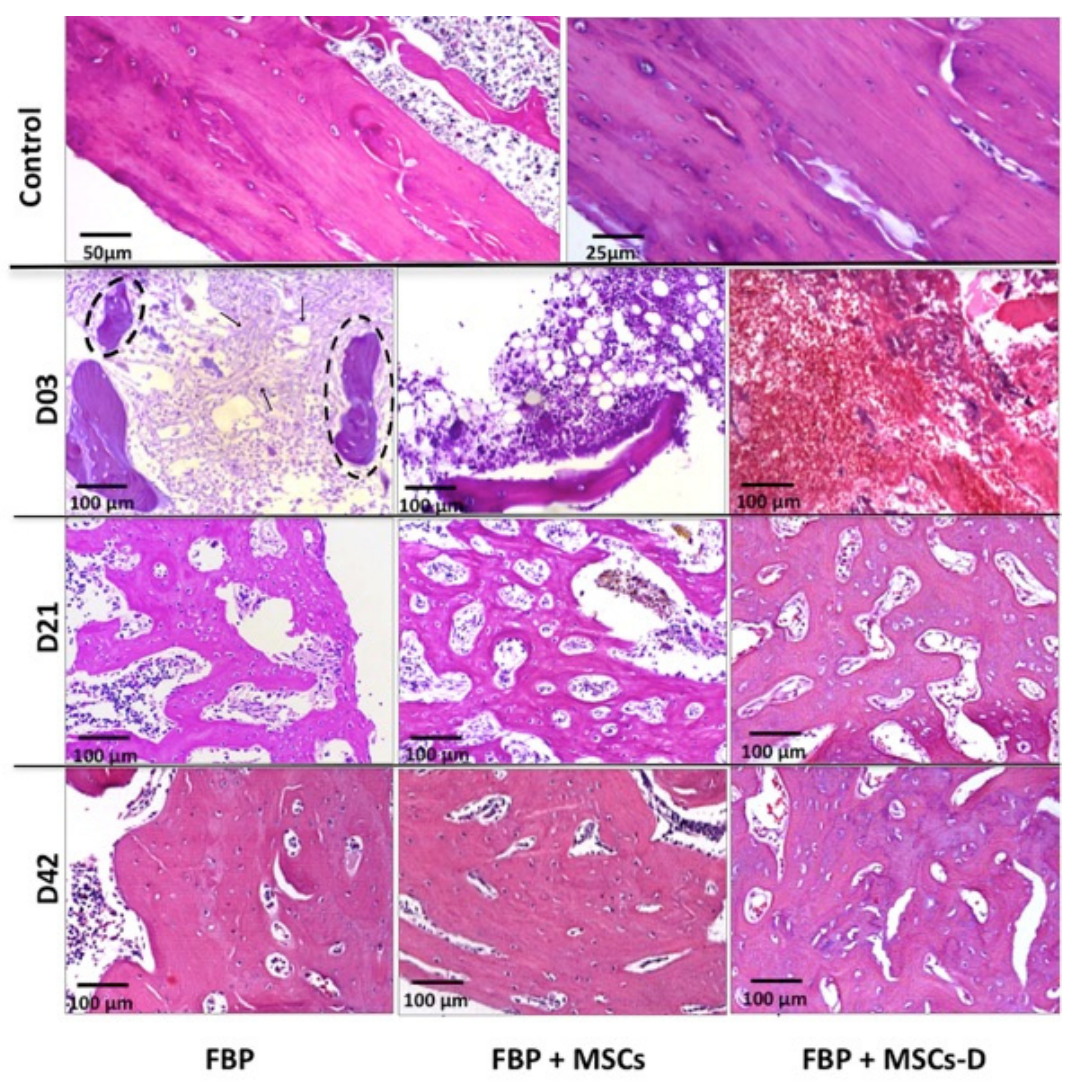
Figure 4. Histological analysis of bone regeneration tissue in femur of rats at 3 (D03), 21 (D21) and 42 (D42) days post injury stained with H&E. FBP (fibrin biopolymer only); FBP + MSCs (fibrin biopolymer + mesenchymal stem cells); FBP + MSC-D (fibrin biopolymer + differentiated mesenchymal stem cells); Control show a non-injured bone for comparison. Arrows: fibrillary material; dashed circle: bone fragments.